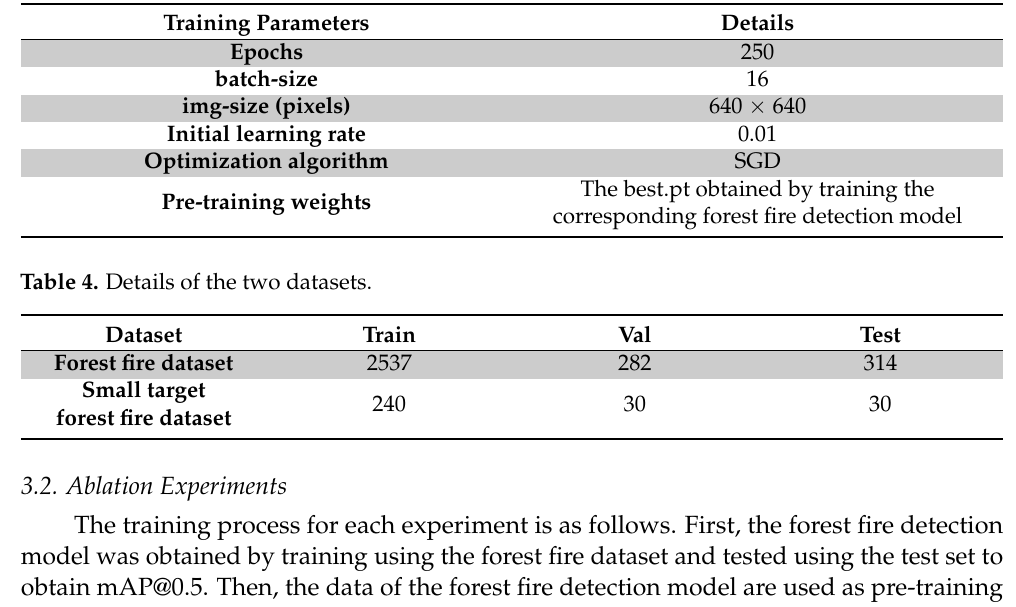
Table 3. Training parameters of the small target forest fire detection model.